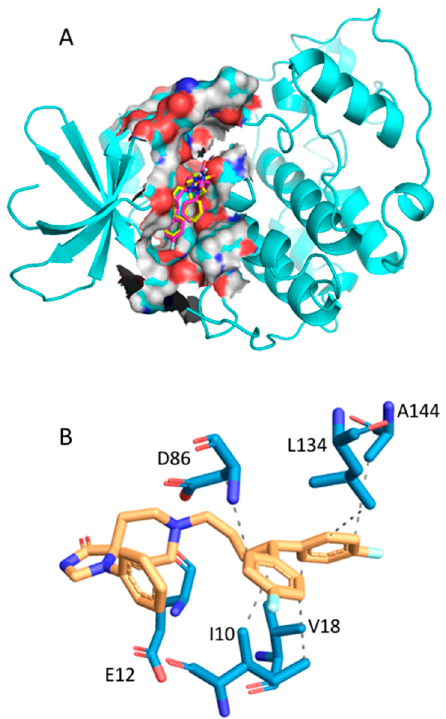
Figure 3. ( A ) Best ‐ scoring fluspirilene binding poses as docked into CDK2 (PDB ID: 1VYZ) by MTiOpenScreen’s Vina (in yellow atom ‐ type sticks) and as minimized by AMMOS2 case 1 (in magenta atom ‐ type sticks). The CDK2 structure is shown in cartoon, and the ATP binding site is shown as spheres. ( B ) PLIP image as generated by the AMMOS2 web server for the fluspirilene binding pose (in yellow atom ‐ type sticks) as minimized by AMMOS2 case 1. The protein residues interacting with the fluspirilene are shown in blue atom ‐ type sticks.